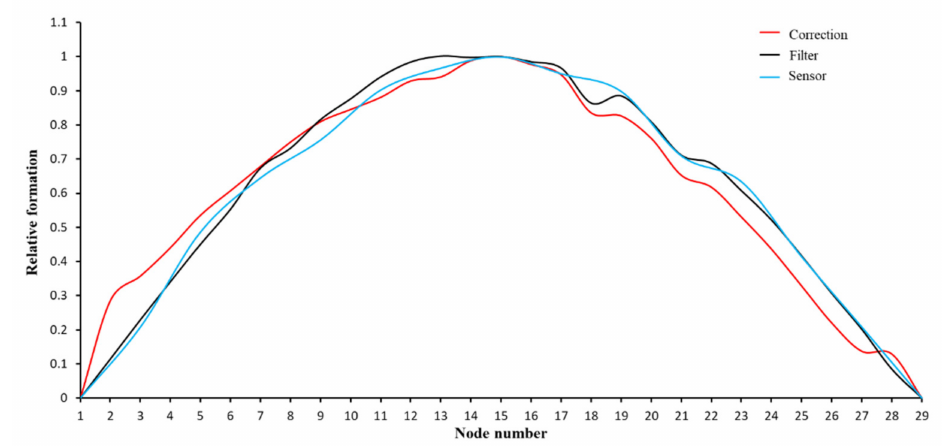
Figure 13. Comparison of the mode shapes identified by three processing